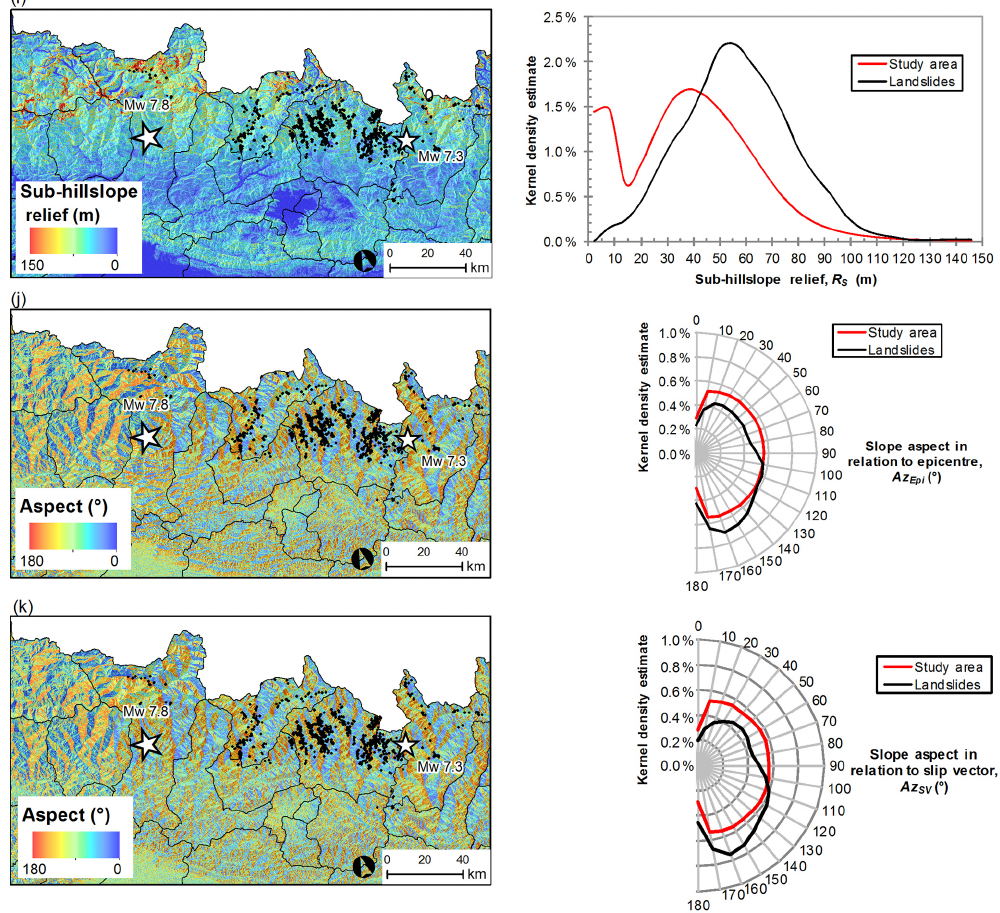
Figure 2. Kernel density estimates of training landslides (black dots, n = 2006) compared to the entire study area for different predisposing factors. (a) Slope angle, (b) Euclidean distance from fault plane, (c) elevation, (d) Euclidean distance from rivers, (e) Euclidean distance from river confluences, (f) planform curvature, (g) normalised ridge–stream distance, (h) hillslope relief, (i) sub-hillslope relief, (j) slope aspect in relation to azimuth to epicentre, and (k) slope aspect in relation to slip vector.